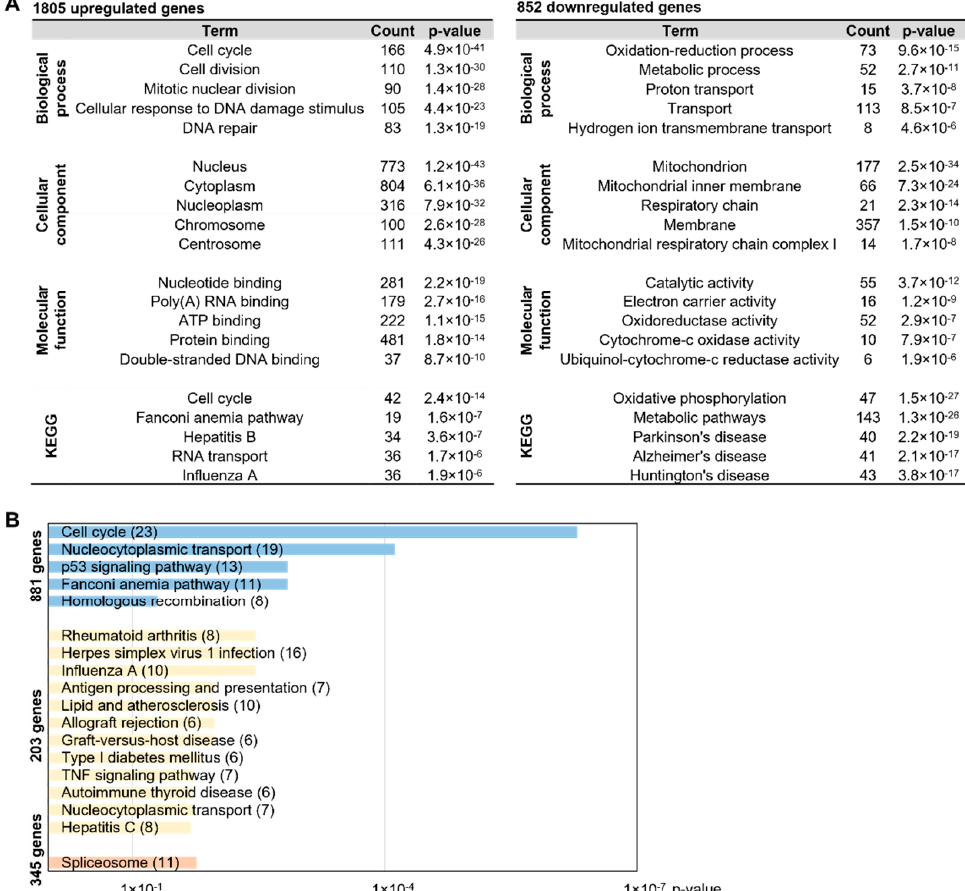
Figure 5. MNC-specific DEGs are involved in disease-related pathways. ( A ) Of the 2657 DEGs from the SNC-MNC comparison, 1805 upregulated and 852 downregulated genes in MNCs were analyzed via GO analysis. The top five highly significant GO terms are revealed. ( B ) Among the DEGs in Figure 1C, 881, 203, and 435 genes were analyzed by GO analysis (q-value < 0.05).